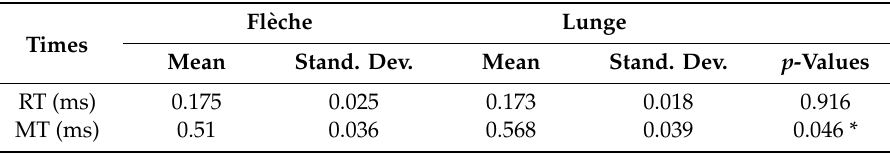
Table 2. Comparison of the mean values of the standard deviation of muscular tension during attacks executed by the fl è che and the lunge. Fl è che Lunge Muscular Tensions Mean Stand. Dev. Mean Stand. Dev. 252.6